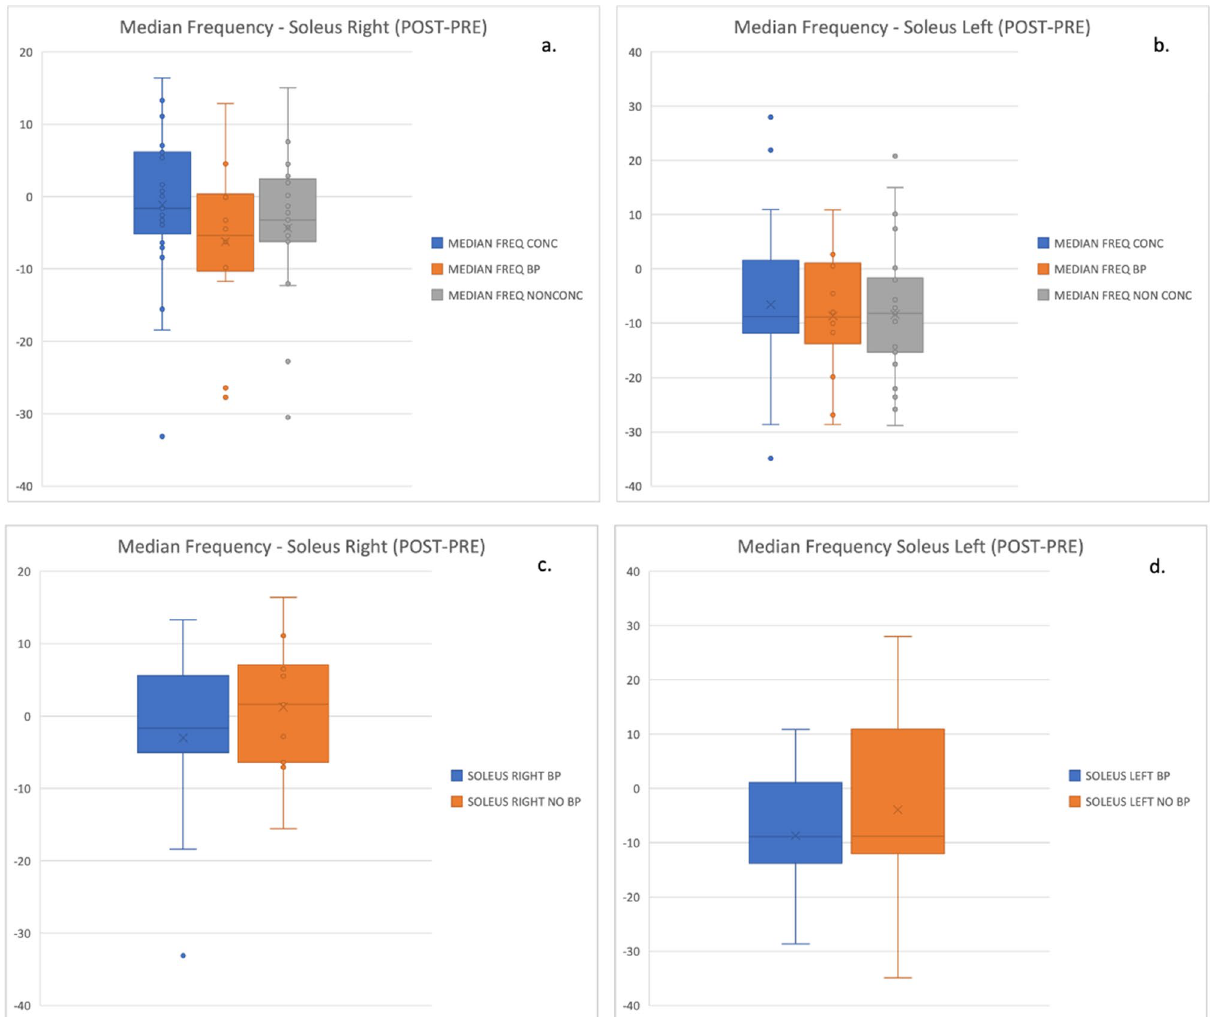
Figure 6. The POST–PRE results for median frequency in the ( a ) right and ( b ) left soleus muscles for the concussion (CONC—blue), concussion with balance problems (CONC BP—orange) and non-concussion groups (NON CONC—grey). Figures ( c ) and ( d ) show the POST–PRE results for median frequency in the left and right soleus muscles for the concussion balance problems vs concussion no balance problems group. When these groups were compared in the POST phase the right soleus showed a significant discrimination between the BP and No BP